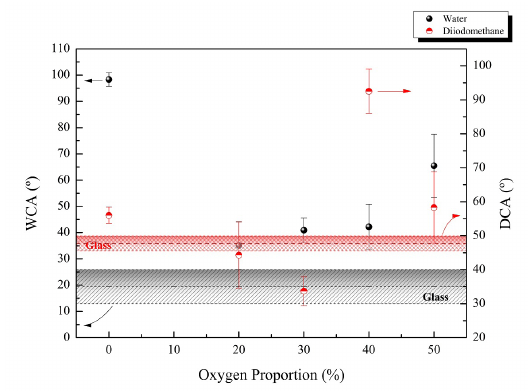
Figure 9. Contact angle as a function of the percentage of oxygen in the feed for distilled water (right axis) and diiodomethane (left axis). Contact angles of the glass substrate are also given by the dashed areas.